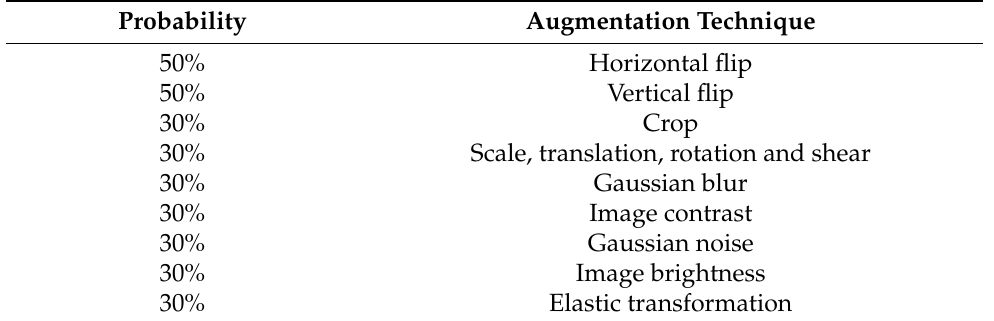
Table 4. The proportion of random image augmentation.